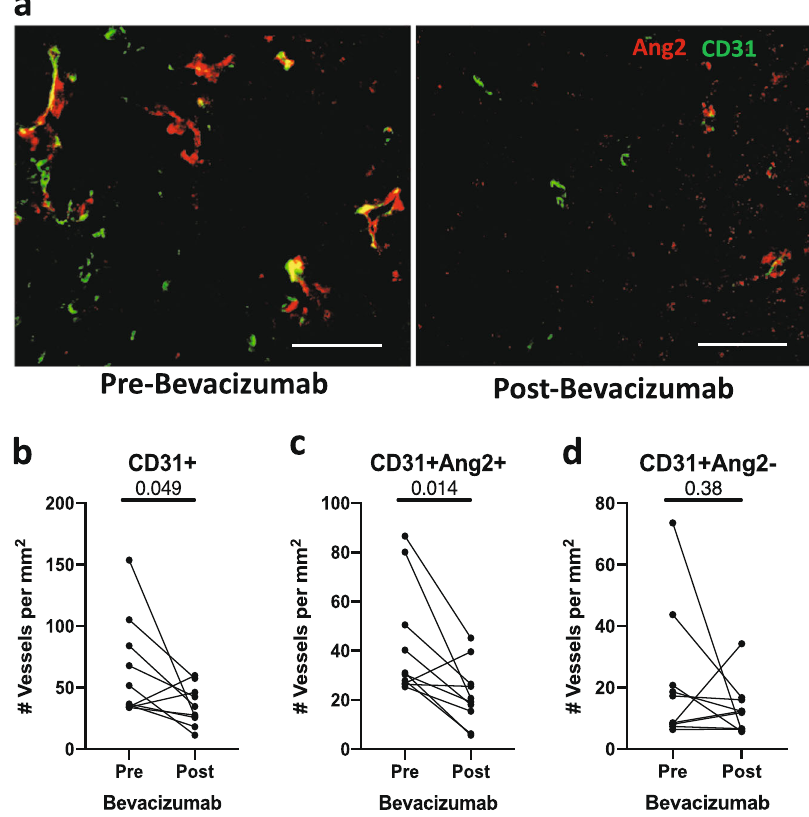
Fig. 1 Bevacizumab reduced the CD31 + Ang2 + vessel density. a Representative immuno fl uorescence for CD31 and Ang2 pre- and post- bevacizumab (images from paired samples of same patient); scale bar = 50 µm. Quantitative analyses of TNBC vessels ( b – d